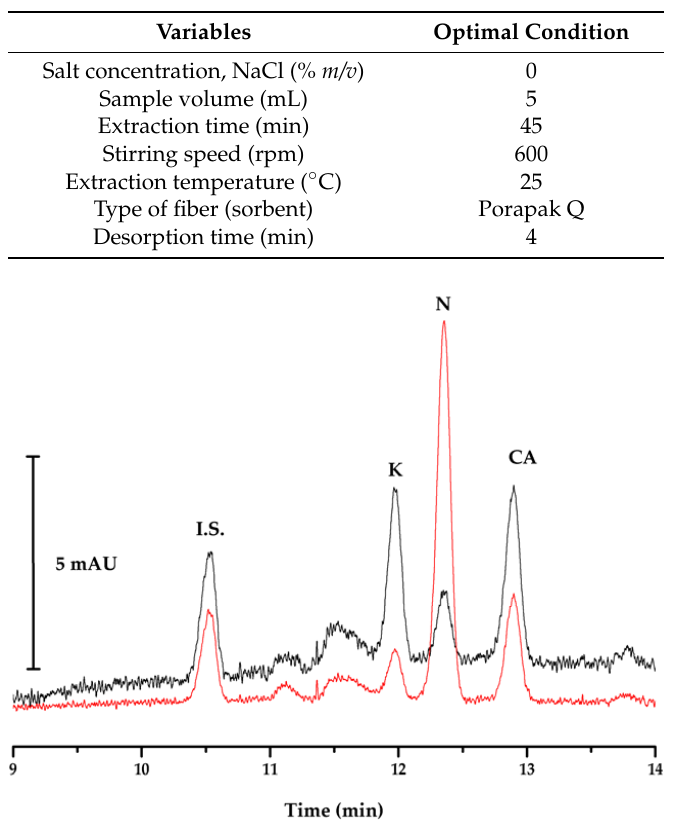
Figure 5. Typical electropherogram obtained under optimum conditions of a standard 30 μ g ∙ L − 1 solution of ketoprofen (K), naproxen (N), clofibric acid (CA), and internal standard (I.S.), at 203 (black) and 228 (red) nm.